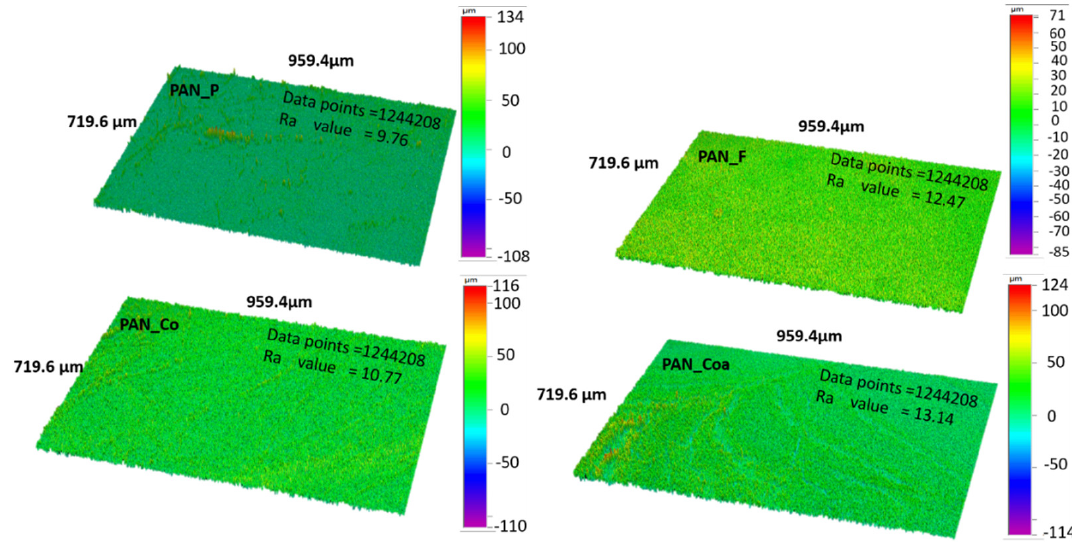
Figure 5. Surface roughness of the PAN_P, PAN_F, PAN_Coa and PAN_Co NFs membranes.